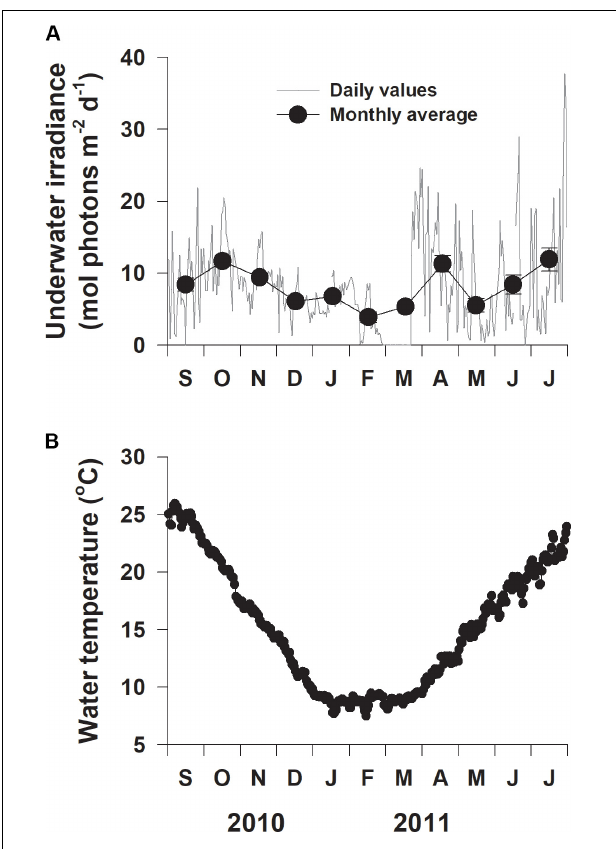
FIGURE 4 | Daily underwater photon flux density (A) and water temperature (B) at the study site on the southern coast of Korea from September 2010 to July 2011.